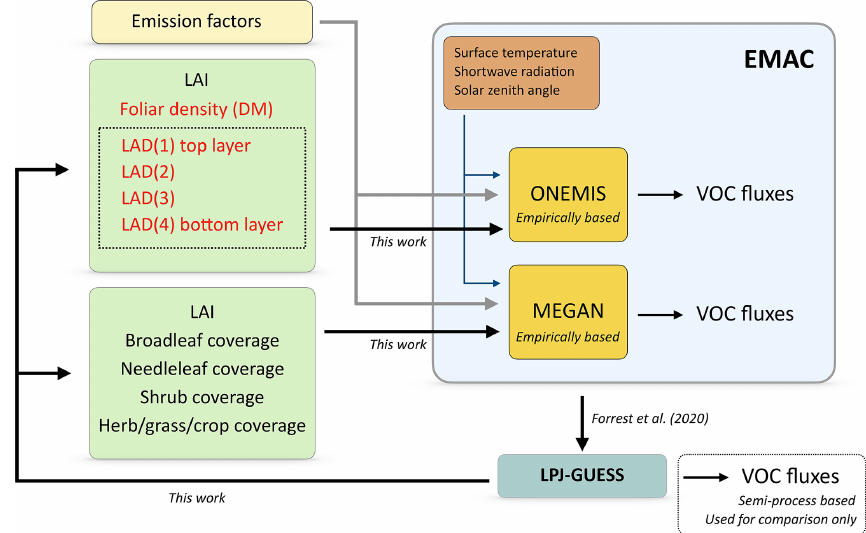
Figure 2. Model set-up for BVOC emission estimates in EMAC. The vegetation variables needed in ONEMIS and MEGAN are now provided by LPJ-GUESS, replacing offline climatological datasets. Vegetation variables that were already available at the interface between EMAC and LPJ-GUESS are in normal black text, while the new vegetation information derived in this work (i.e. foliar density and the LAD distribution) are in red text. Note that, in EMAC, only empirically based emissions are considered. VOC fluxes from the semi-process-based module in LPJ-GUESS are only used for